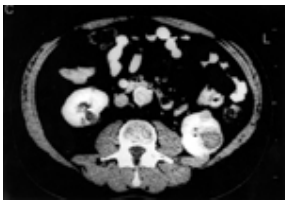
FIGURE 1 . CT scan: Benign small cyst and cystic 4x5 cm renal cell carcinoma at the lower pole of the left kidney; TNM: pT1 N0 M0 G 1.